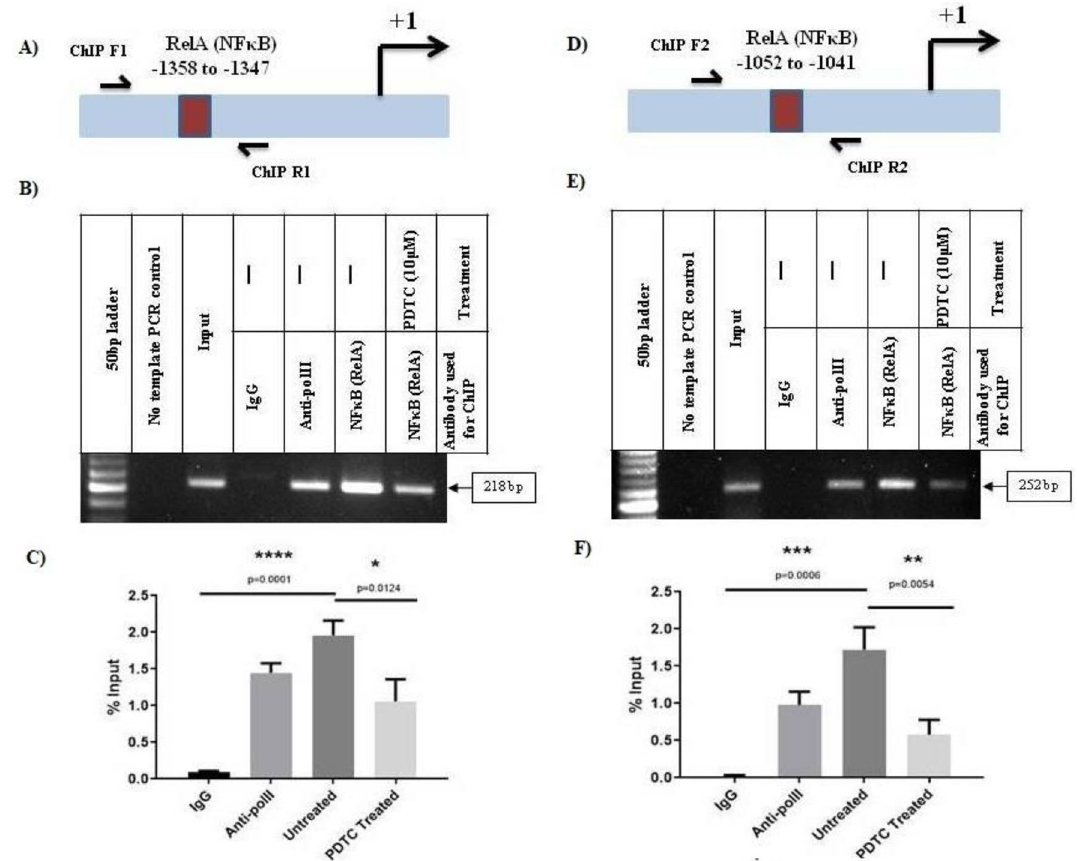
Figure 6. In vivo binding of NFκB (RelA) to its cognate motifs on human hnRNPD promoter. ( A ) Schematic representation depicting the positions of RelA (NFκB) binding motifs − 1358/− 1347 in the hnRNPD promoter and primers used for ChIP assay. Cross linked chromatin from PDTC treated or untreated SCC-4 cells was immunoprecipitated with anti-RelA antibody and subjected PCR after reversal of cross linking and sonication using the primers depicted in the supplementary Fig. S3. Sonicated genomic DNA from SCC-4 cells was used as input. Chromatin immunoprecipitated with Anti-pol II antibody was subjected to PCR using GAPDH primers and served as positive control. While PCR with gene specific primers and chromatin immunoprecipitated using normal mouse IgG served as negative control (IgG lane). Similarly, PCR performed with gene specific primers without a template also served as control. A 50 bp DNA ladder was used to determine the size of PCR fragments on agarose gel. ( B ) Representative agarose gel image of ChIP assay for RelA (NFκB) binding motifs − 1358/− 1347. ( C ) Densitometric quantification PCR fragment of ChIP assay for RelA (NFκB) binding motifs − 1358/− 1347. Values are mean ± SD from there independent experiments. Results were analyzed by Student’s t test and values significantly different from respective controls have been marked by stars (*P ≤ 0.05, ****P ≤ 0.0001). ( D ) Schematic representation depicting the position of RelA (NFκB) binding motif (− 1052/− 1041) in hnRNPD promoter) and primers used for ChIP assay. ( E ) Representative agarose gel image of ChIP assay for RelA (NFκB) binding motifs (− 1052/− 1041). ( F ) Densitometric quantification PCR fragment of ChIP assay for RelA (NFκB) binding motifs (− 1052/− 1041). Values are mean ± SD from three independent experiments. Values significantly different from respective controls have been marked by stars (**P ≤ 0.01, ***P ≤ 0.001). Other details are same as described for RelA (NFκB) binding motifs − 1358/− highest promoter activity. This was in agreement with our previous report on the levels hnRNPD protein in these cells 20 . Elevated hnRNPD promoter activity has also been reported in breast cancer cells 17 . By nucleotide